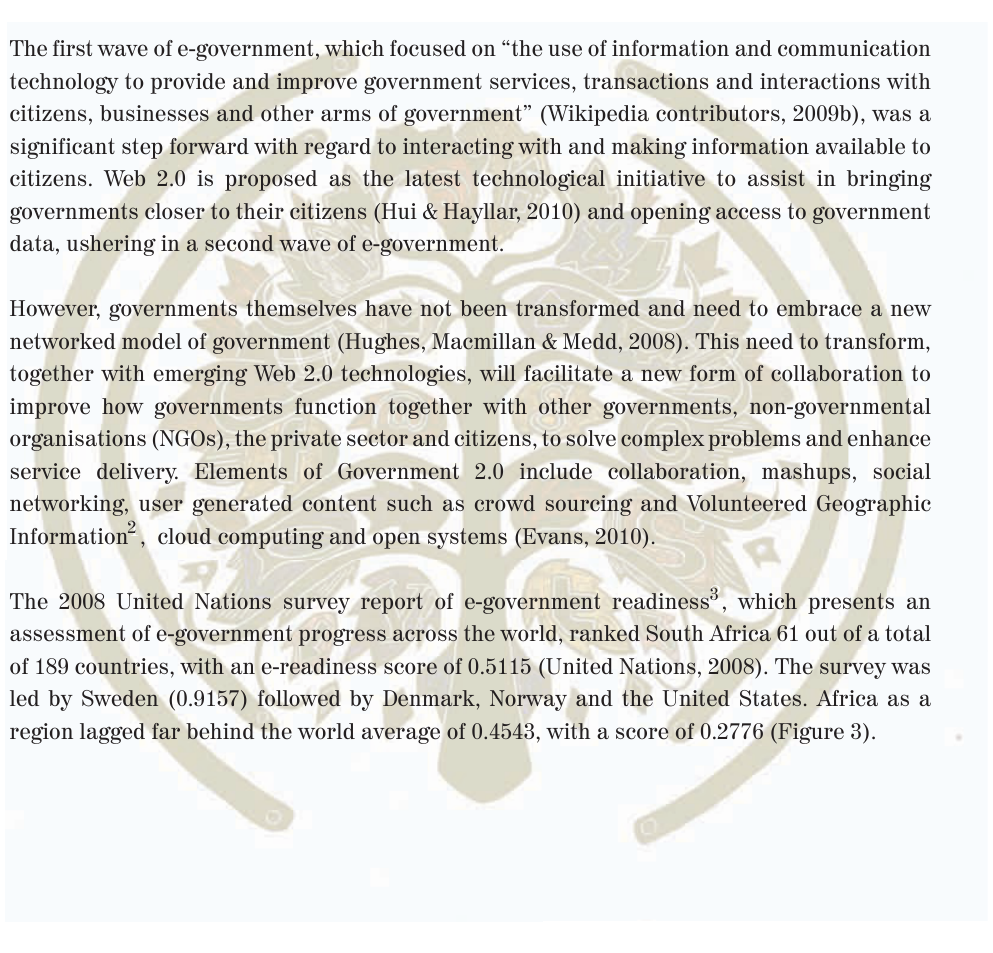
Source: United Nations, 2008